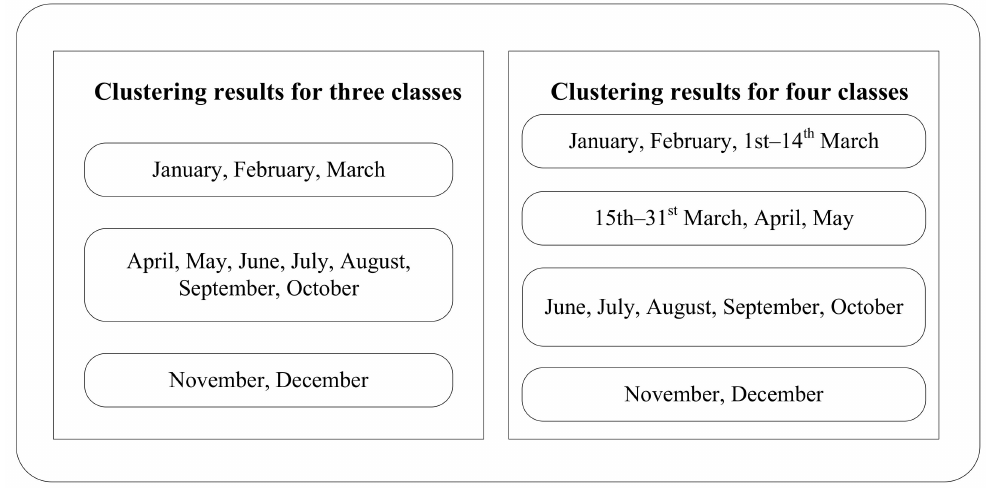
Figure 5. Clustering results of di ff erent quantity